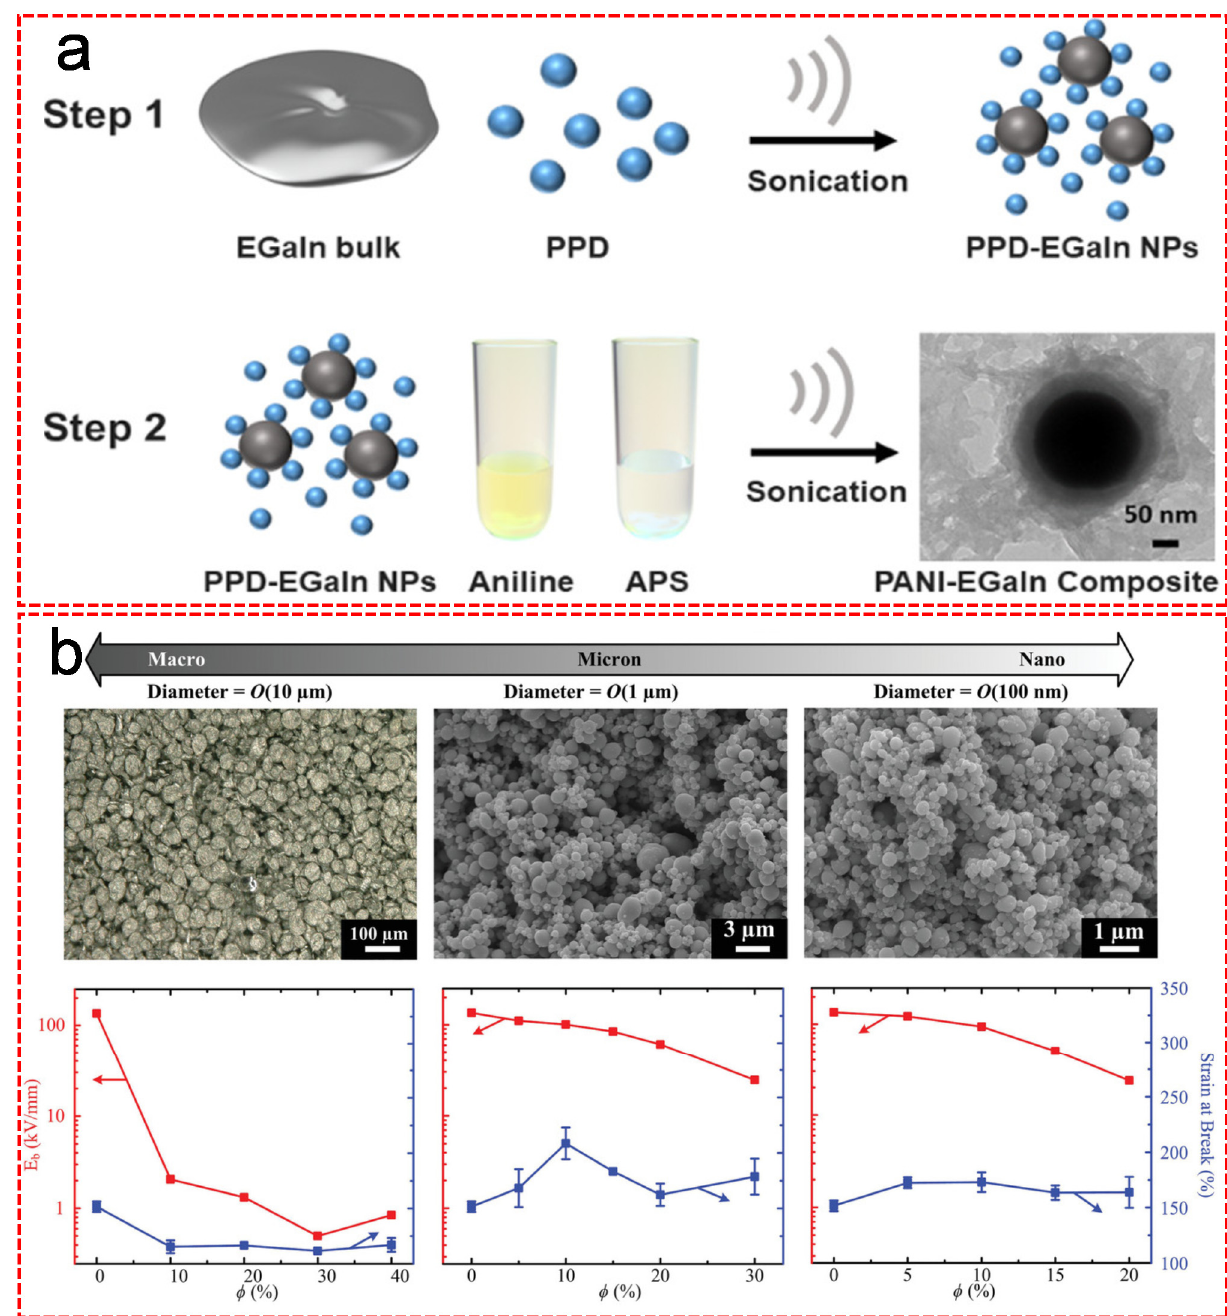
Figure 4. Synthesis of LM-polymer composites. ( a ) Synthesis of the PANI-EGaIn nanocomposites with the PPD polymerization enhancer. Reproduced with permission. [33] Copyright 2020, American Chemical Society. ( b ) The effect of sizes of LM particles on the dielectric and mechanical properties of the LM-polymer composites. Reproduced with permission. [34] Copyright 2019, WILEY-VCH.